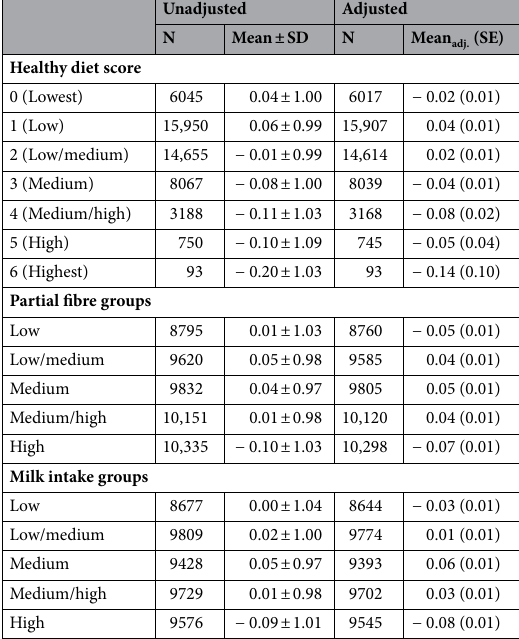
Table 4. Unadjusted and covariate adjusted descriptive statistics for cognitive ability scores across healthy diet score, partial fibre, and milk intake groups.